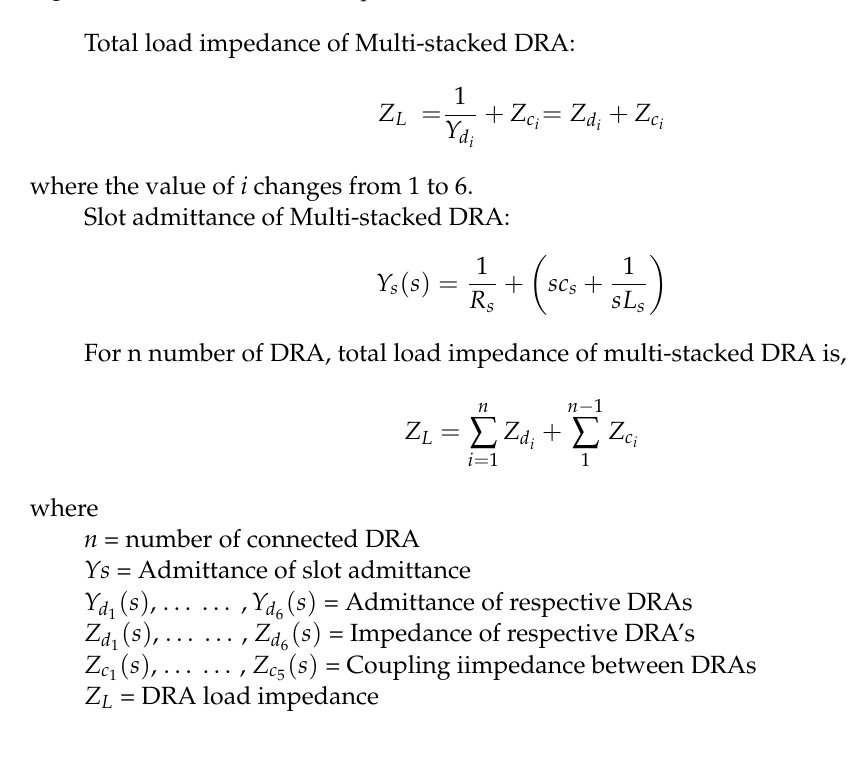
Figure 2. Multi-stacked DRA simplified circuit.